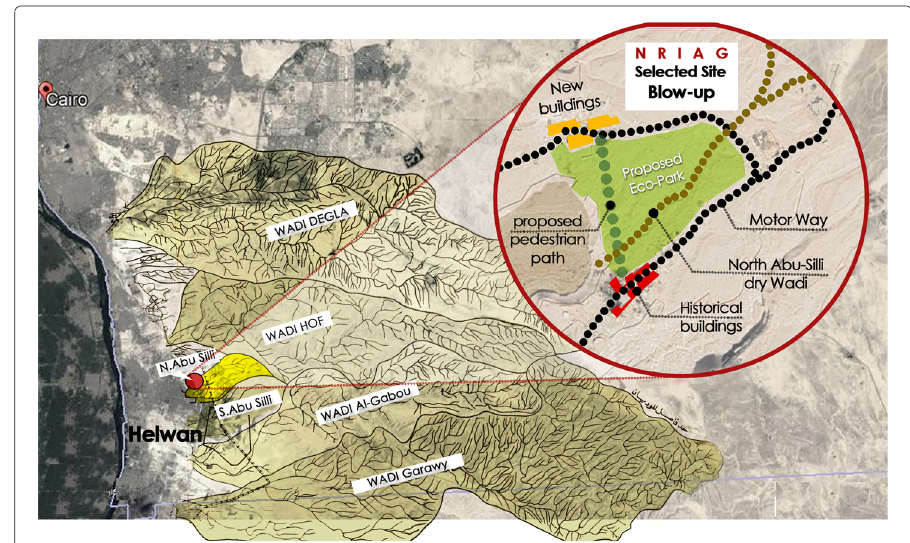
Fig. 1 Google satellite image showing the 6 Wadis of South-East Cairo, focusing on NRIAG site. Source: Authors, adapted based on [18]